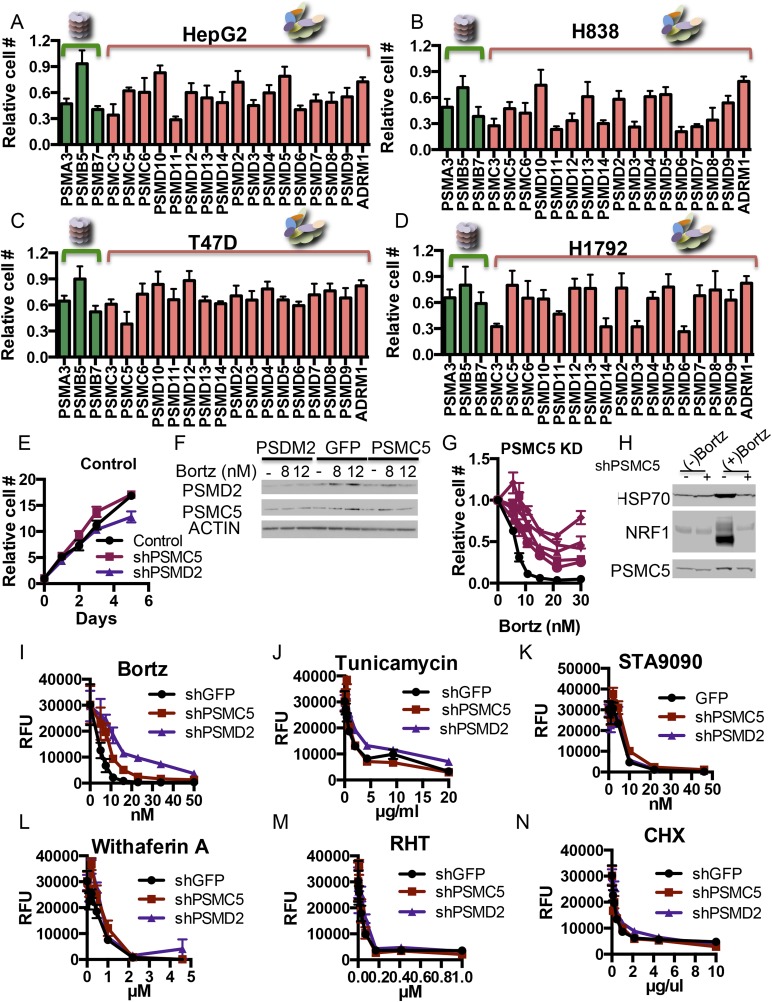
(A–D) Examining the effect of proteasome subunit knockdown in different cell lines.80 shRNAs targeting 20 different proteasome subunits and control hairpins were expressed in HepG2 (A), H838 (B), T47D (C), and H1792 (D) cells by viral transduction. Each subunit was targeted by 4 different shRNAs and the cell viability was measured as the relative cell number compared to the average of non-targeting shRNAs 5 days after the initial introduction of the shRNAs. (E, F) HepG2 cells with shRNAs targeting PSMC5, PSMD2, and green fluorescent protein (GFP) were grown out. Their relative growth was analyzed in the absence of bortezomib (E) and their protein content was analyzed 24 hr after the addition of either 8 or 12 nM of bortezomib (F). (G) The relative cell number of cells harboring a control shLacZ (black) or each of 5 individual shRNAs targeting shPSMC5 (Cayenne) was analyzed 4 days after addition of the indicated concentrations of bortezomib. (H) HepG2 cells stably expressing shRNAs targeting the PSMC5 subunit and a control shRNA (lacZ) were analyzed by Western blot for the indicated proteins 24 hr with or without bortezomib treatment. (I–N) The HepG2 cells with shRNAs targeting PSMC5, PSMD2, and GFP (described above) were further exposed to a short panel of stress inducers including bortezomib (I), tunicamycin (J), rohinitib-RHT (K), Hsp90 inhibition (L), withaferin A (M), and cyclohexamide (N) at indicated concentrations and the relative cell number (RFU) was examined after 4 days. The graphs represent the average of at least 4 different measurements and the SEM.